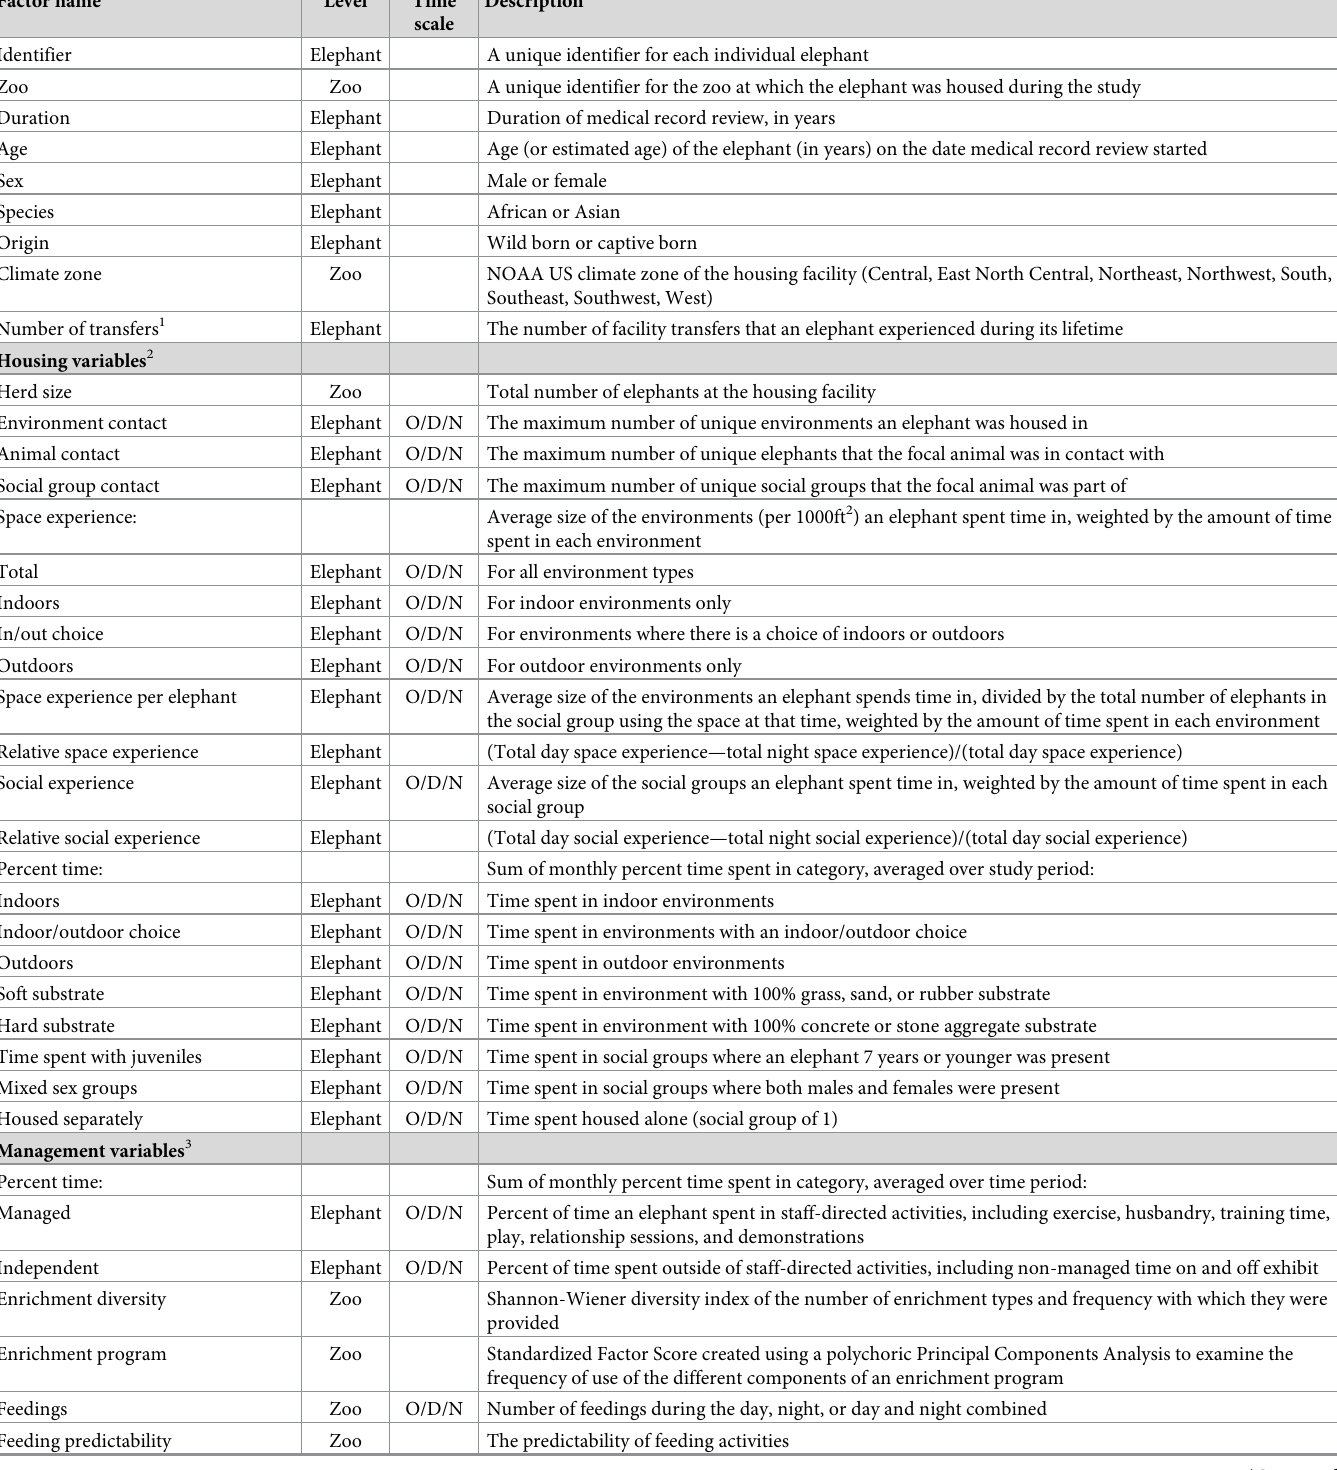
Table 3. Description of variables used in the analysis of the number of clinical events recorded during the 12-month study period in African and Asian elephants in North American